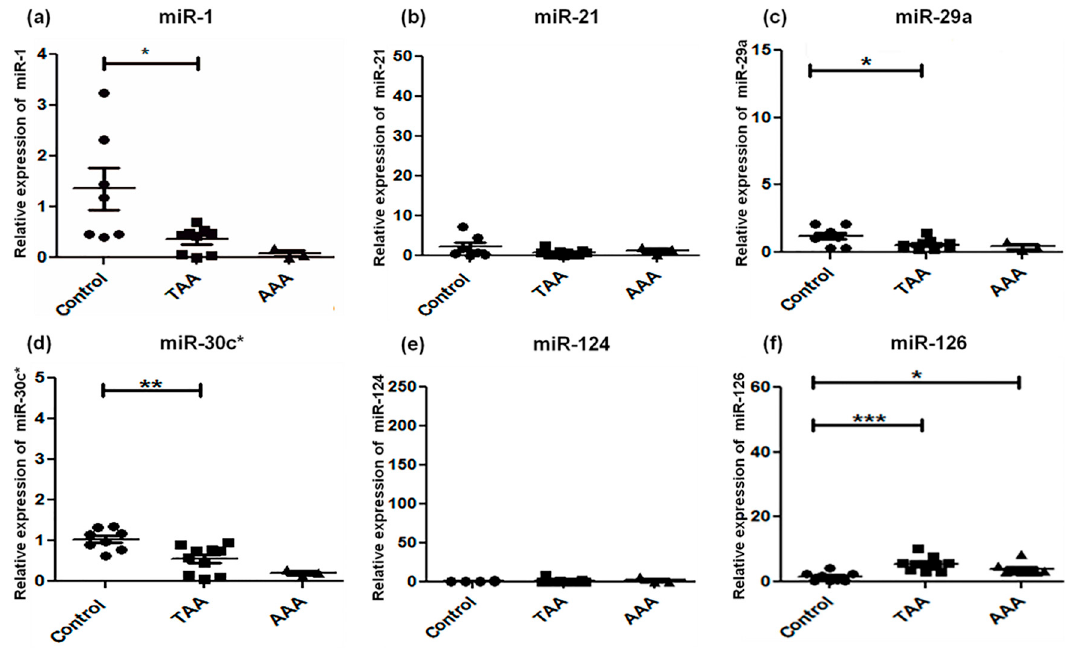
Figure 1. Alterations in microRNA profiles of miR-1 ( a ), miR-21 ( b ), miR-29a ( c ), miR-30c-2* ( d ), miR-124 ( e ), and mir-126 ( f ) by qRT-PCR. Expression levels in TAA ( n = 11) and AAA ( n = 3) as compared with non-aneurysmal control aorta ( n = 8). The relative amount of each miRNA was normalized to small nucleolar RNA (RNU44). Statistically significant differences: * p < 0.05, ** p < 0.01, *** p < 0.001.